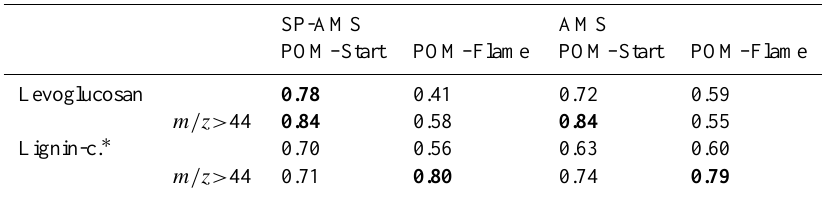
Table 2. Uncentred correlations, excluding H x O + , of the OM mass spectra from PMF with literature AMS spectra (Aiken et al., 2007; Ulbrich et al., 2009, 2014). Correlations over 0.75 are